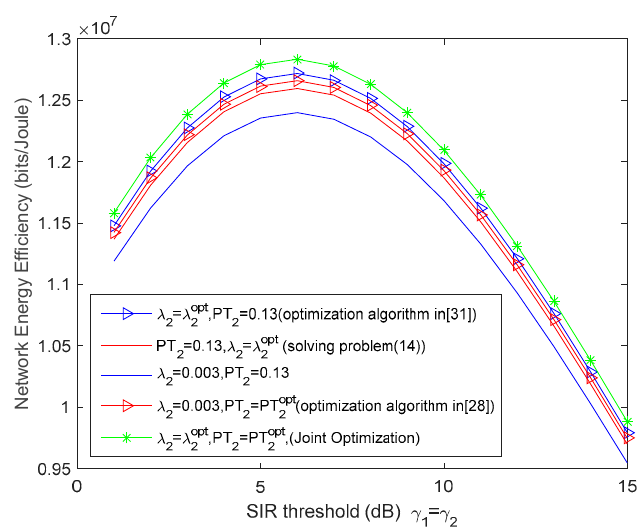
Figure 4. Network EE with fixed picocell BS density and optimal picocell BS density. Note: SIR = signal-to-interference ratio.